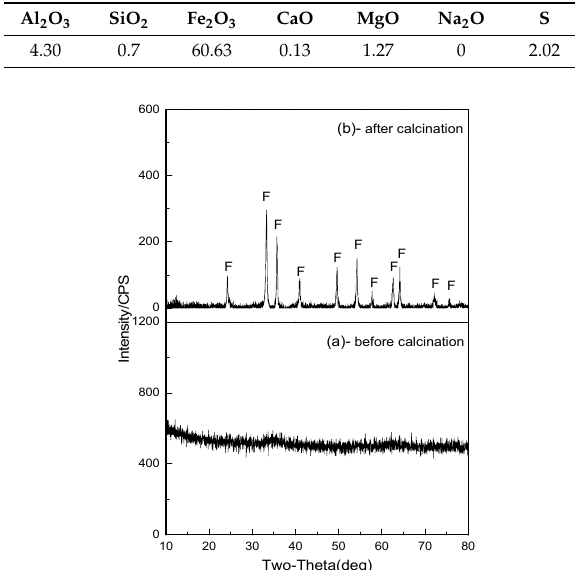
Figure 6. XRD patterns of the precipitate ( a ) before and ( b ) after calcination (F-Fe 2 O 3